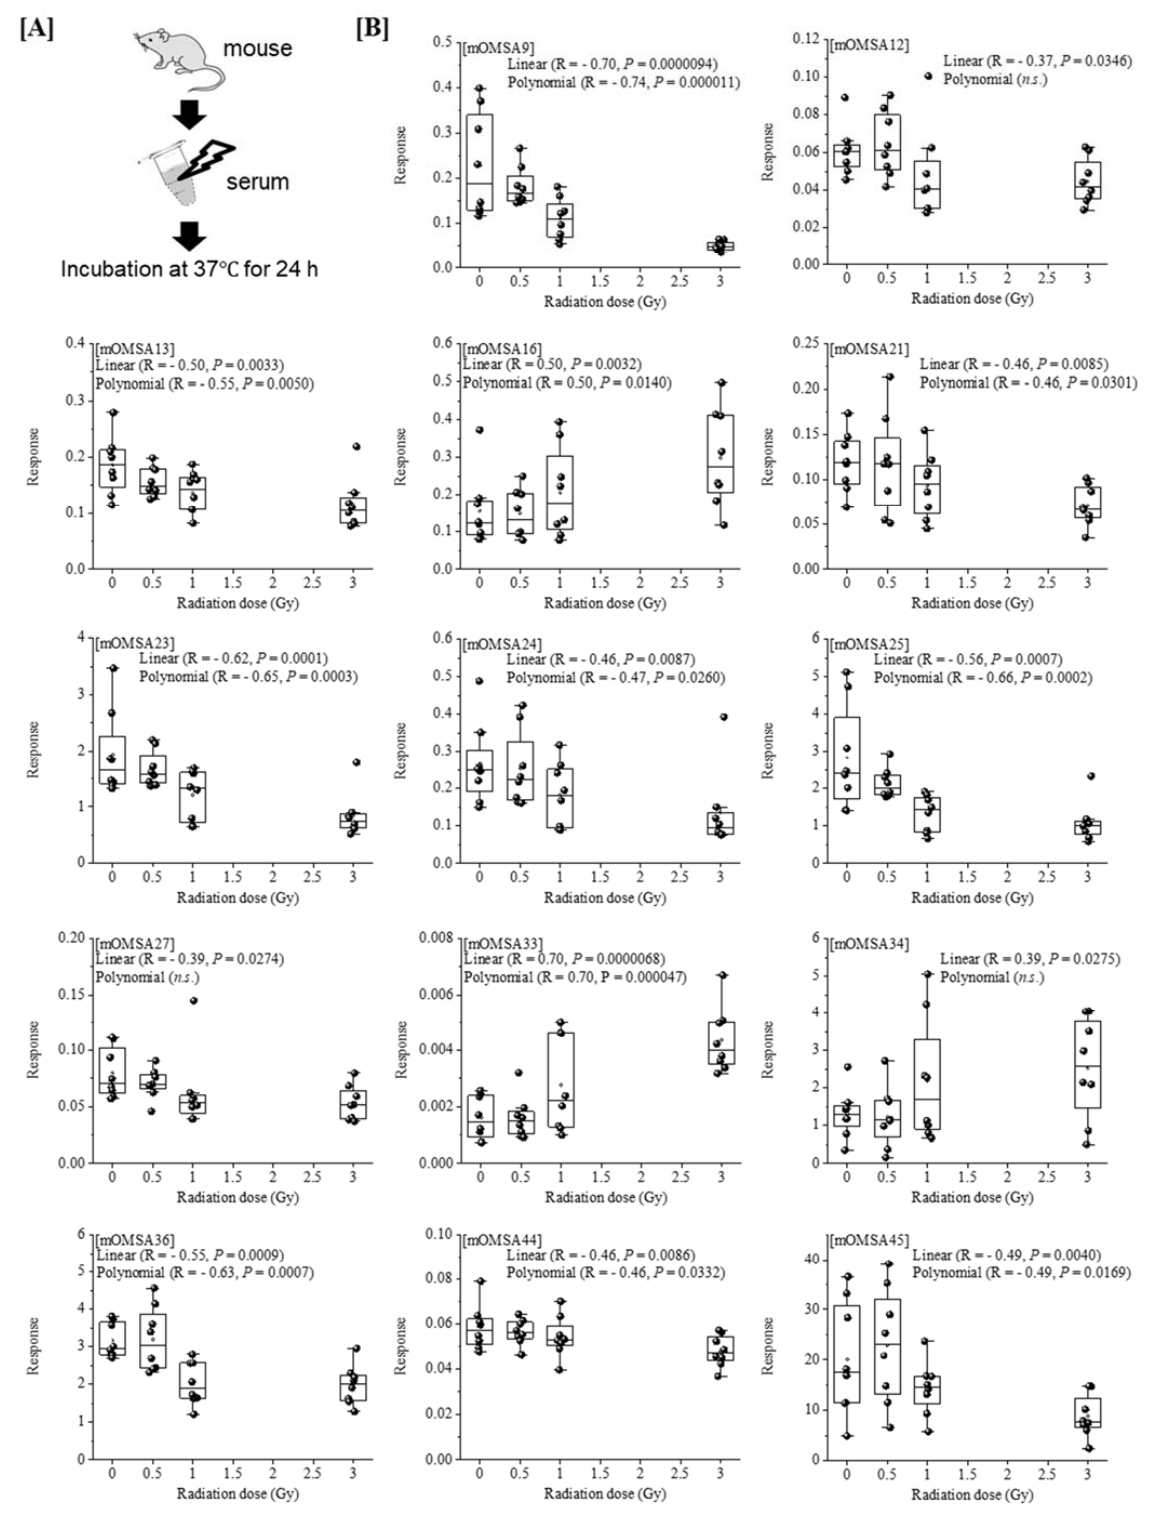
Figure 4. Correlation between oxidative modification sequence of MSA irradiated in